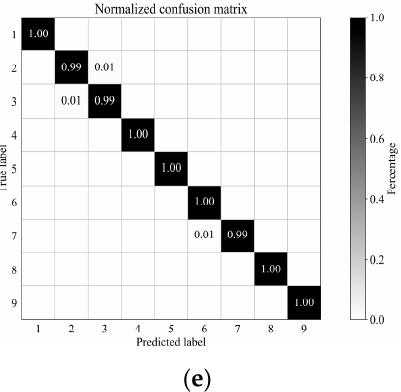
Figure 13. University of Pavia: Normalized confusion matrix of classification results using different methods (displaying value greater than 0.005): ( a ) SSLSTMs, ( b ) 3D CNN, ( c ) FDSSC, ( d ) SSRN, ( e ) SSCC.